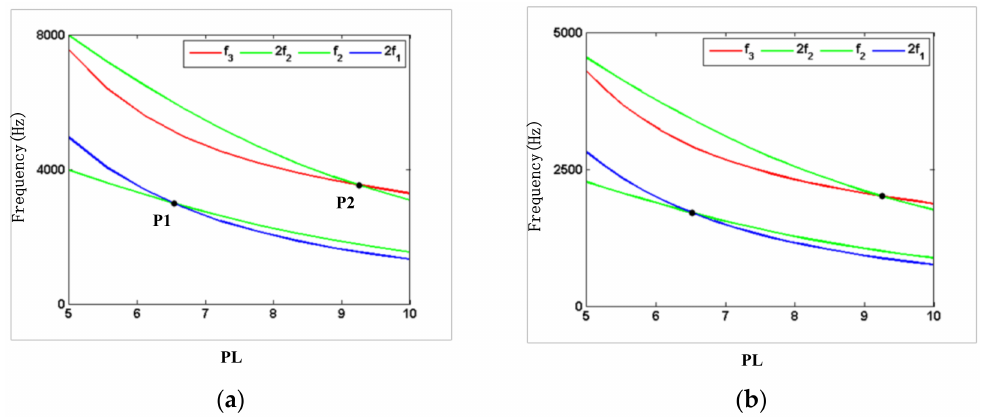
Figure 7. Internal resonant frequency of the resonator at a fixed-width ratio: ( a ) silicon; ( b ) steel.